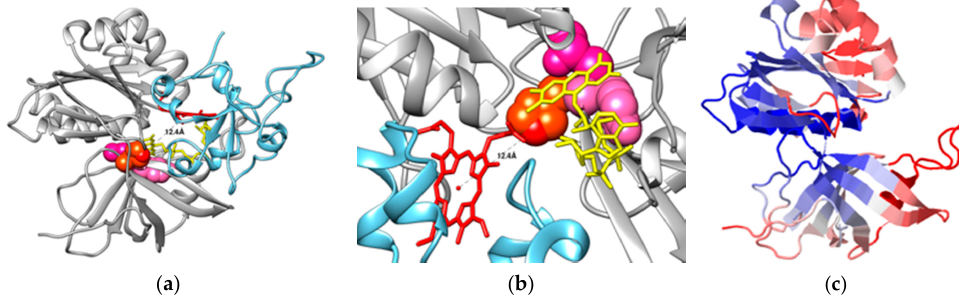
Figure 3. Representation of the C b 5 :C b 5 R complex model obtained by docking and representation of C b 5 R areas that are susceptible for mobility through intraprotein dynamics. The C b 5 :C b 5 R complex model has been previously published [37]. C b 5 R’s backbone is shown in grey color, with side-chain residues of Y93, T94, and H77, which are represented as light pink, dark pink, and red-colored balloons, respectively, the flavin group depicted as sticks in yellow interact with the heme group (represented as red sticks) of C b 5 backbone (represented in light blue color). Also, a distance of 12.4 Å from the iron heme group of C b 5 to NE2 of H77 was measured and labeled, as shown in panel ( a ). The zoomed area where a distance of 12.4 Å was found between the iron heme group of C b 5 and NE2 of H77 is shown in panel ( b ). The chain corresponding to C b 5 R (1UMK) from our model for the C b 5 :C b 5 R complex was submitted to the dynOmics portal, as indicated in the text, and a figure representing C b 5 R was obtained, where the size of fluctuations by the lowest frequency (slowest) two Gaussian network model (GNM) modes (blue: almost rigid; and red: highly mobile), as indicated by the color bar under the diagram window) (panel ( c )).